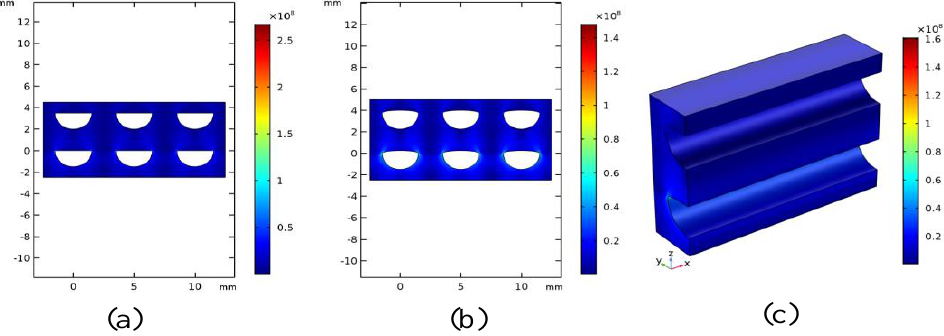
Figure 8. The von Mises stress distribution ( a ) without additional channel radius ( b ) under a 0.25 mm additional channel radius; ( c ) along the channel under a 0.25 mm additional channel radius.